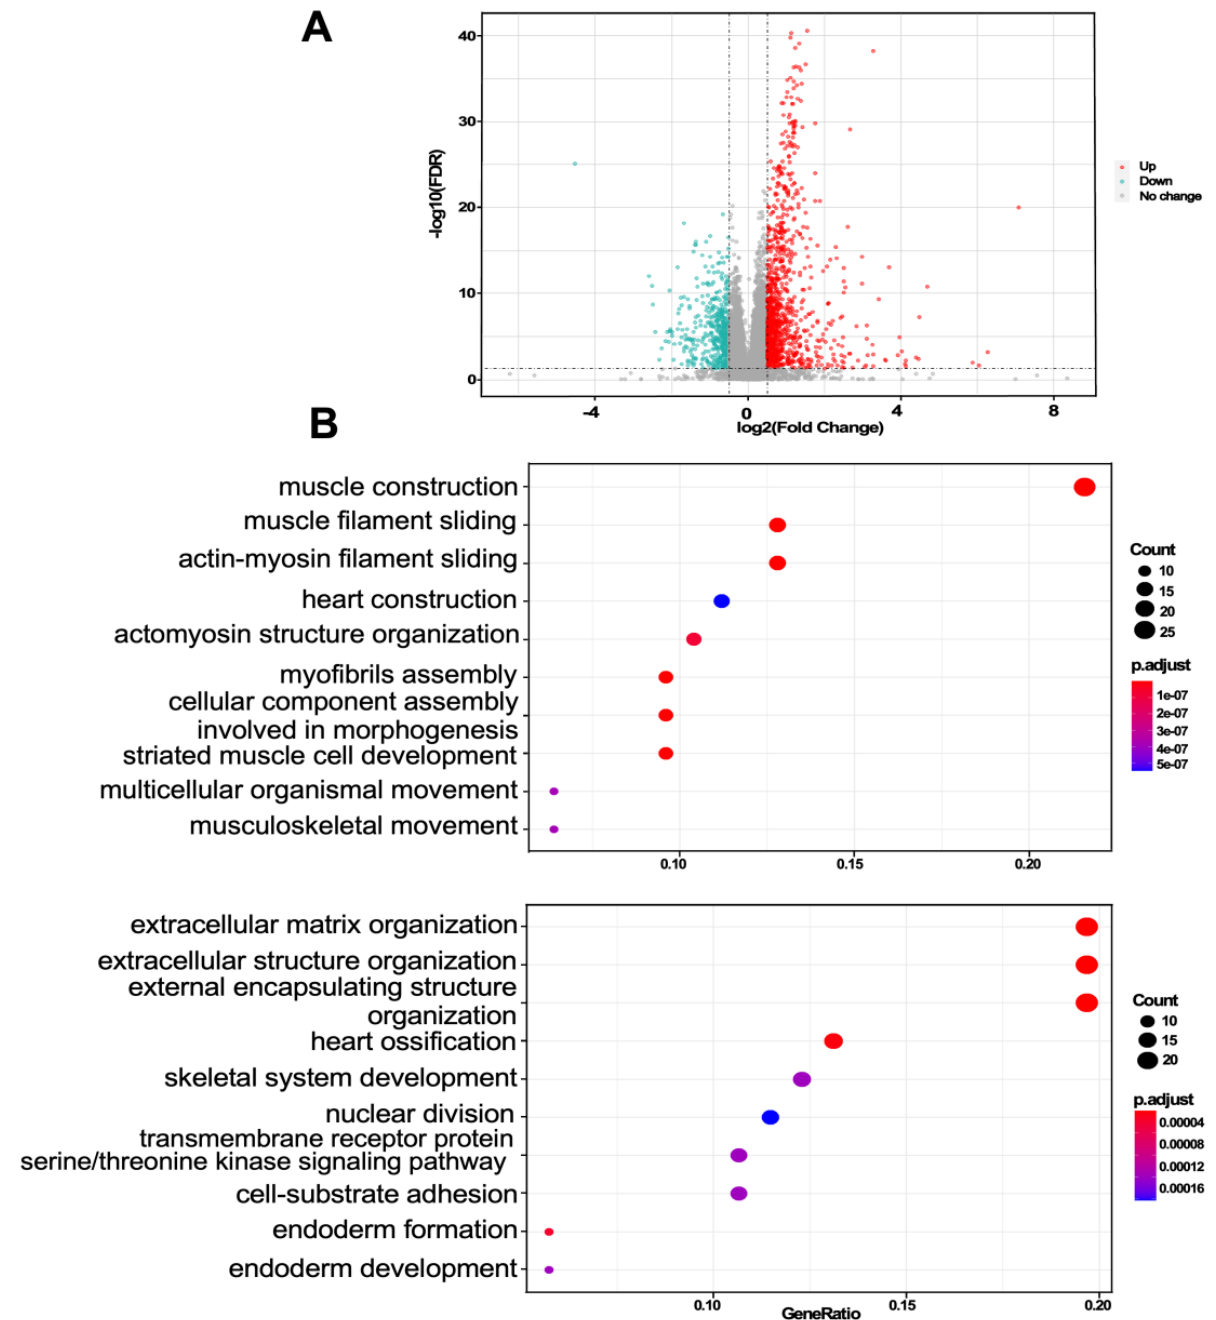
Figure 2. Differentially expressed and functional enrichment analysis. ( A ) Volcano plot of DEGs between PCa patients with low and high GS. Red represents upregulated genes, and blue indicates downregulated genes. ( B ) Gene Ontology biological process analysis of the DEGs.